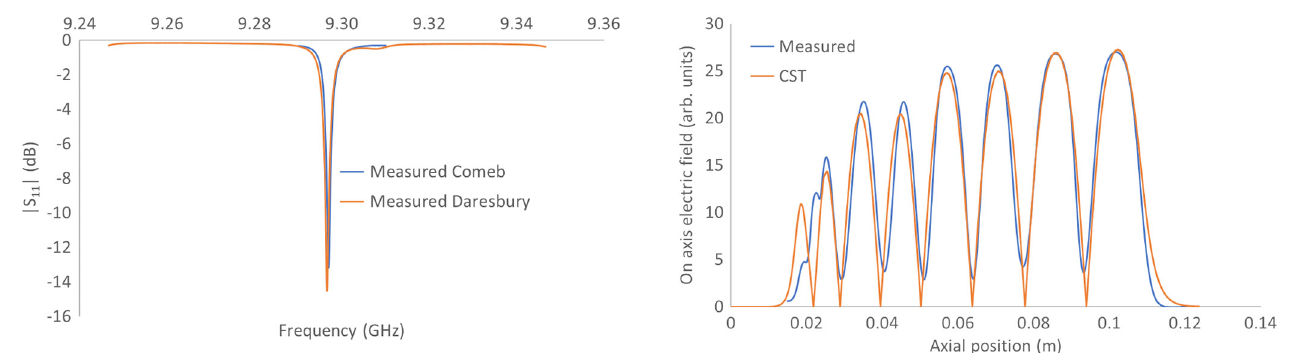
FIG. 16. Field profile plot showing how the electric field varies along the axis of the cavity. The orange line shows the measured field profile after tuning and the blue line the expected field profile.